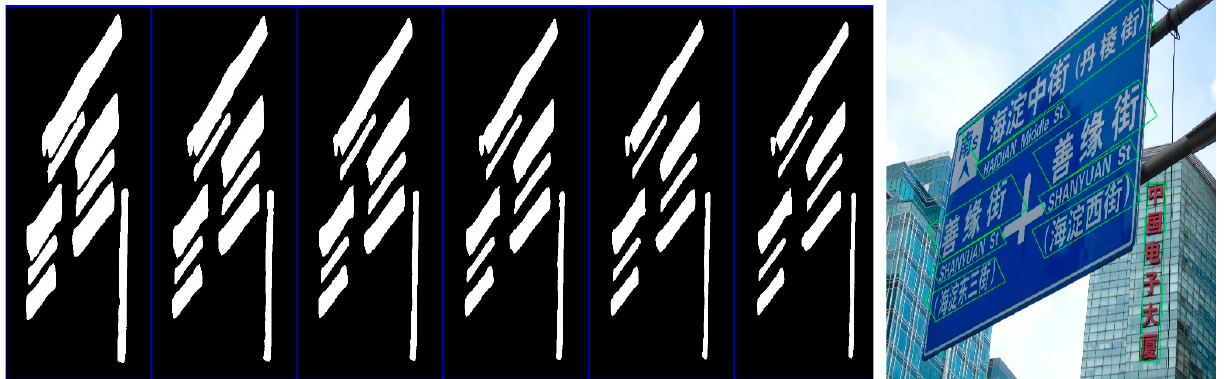
Figure 8. Visualization results of the binarization and multilingual text detection with different ker-